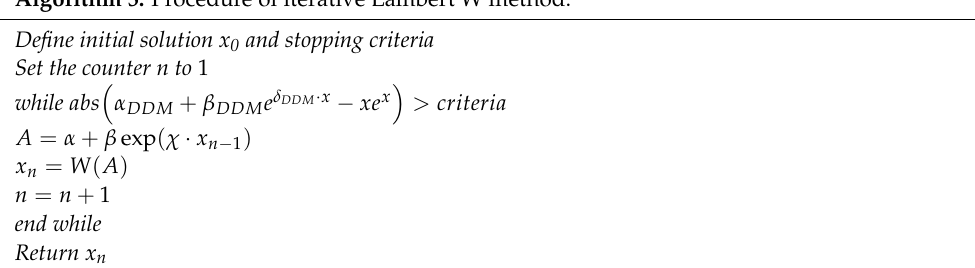
Algorithm 5: Procedure of iterative Lambert W